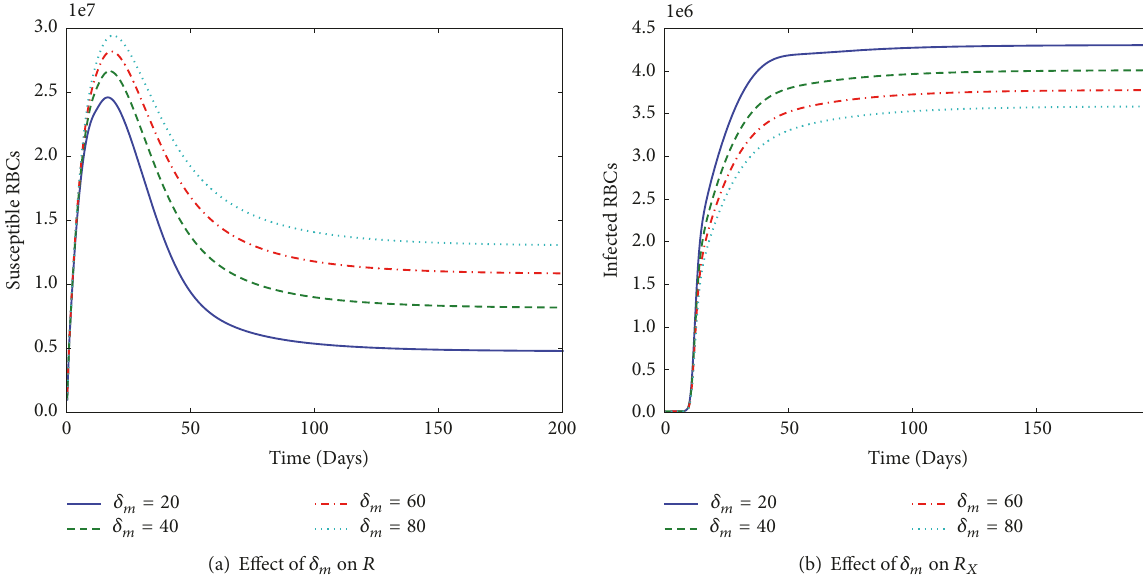
Figure 6: Graphs showing the behaviour of (a) susceptible RBCs and (b) infected RBCs. They were obtained by varying the death rate of merozoites 𝛿 𝑚 from 20 to 80 in steps of 20, while keeping the other parameters (see Table 3) constant.